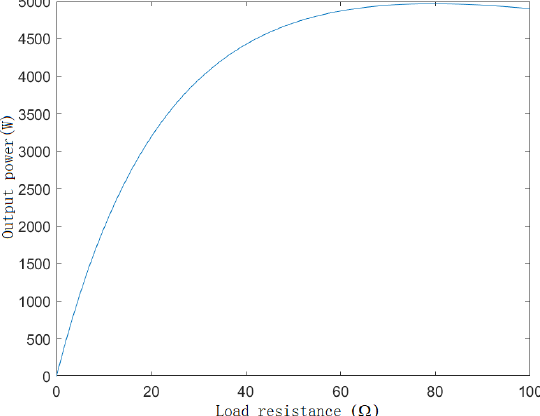
Figure 6. Relationship between output power and load resistance under the two coils.